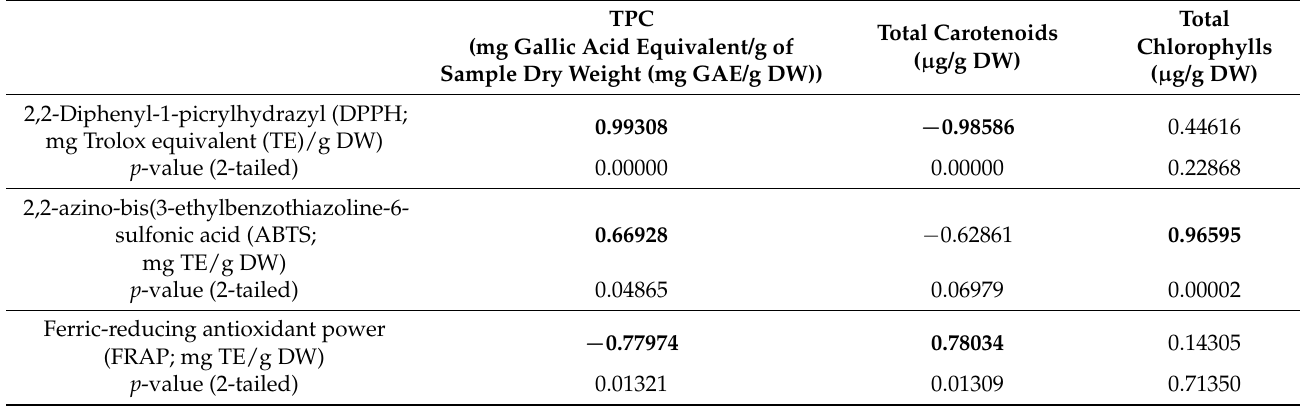
Table 1. Pearson correlation coefficients between the phytopigments, TPC, and antioxidant activity of avocado extracts.